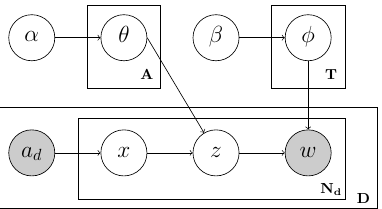
Figure 2: Generative model in plate notation of the Author-Topic (AT)